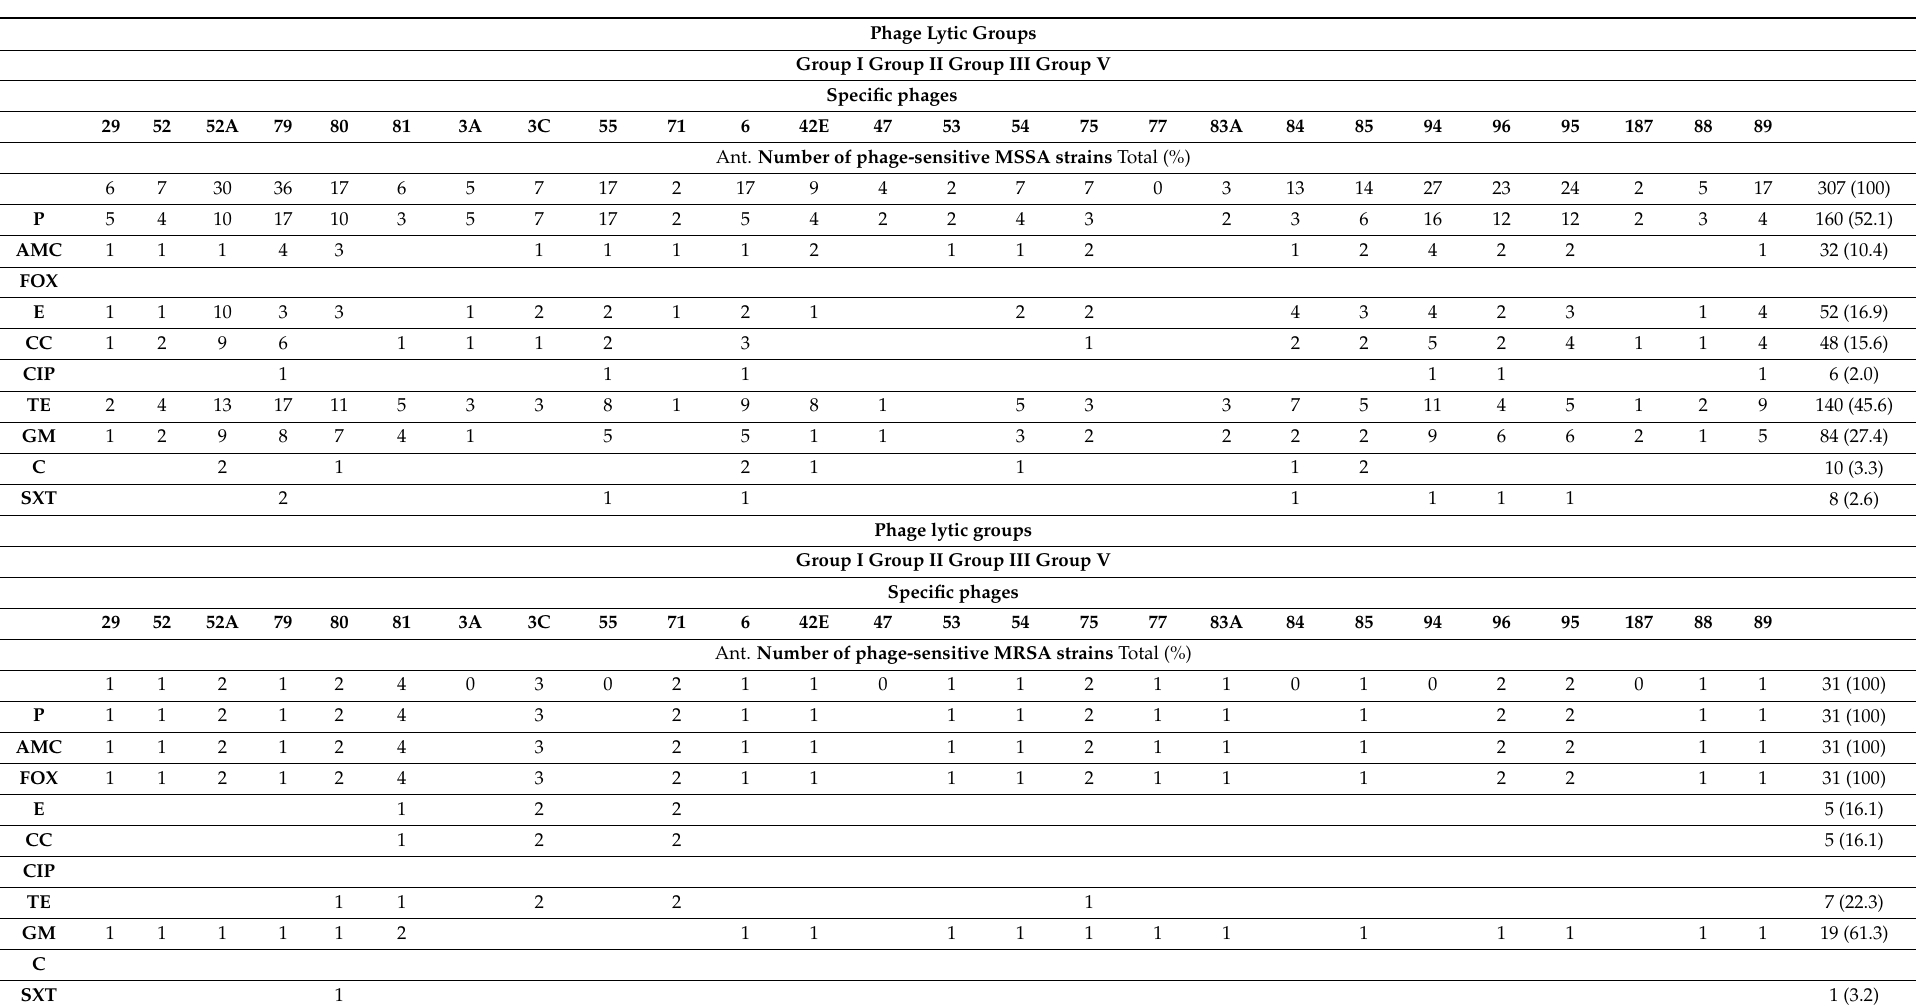
Table 2. Sensitivity to specific lytic phages of MSSA and MRSA 110 oral S. aureus strains and their antibiotic resistance. P—penicillin; AMC—amoxicillin/clavulanic acid; FOX—cefoxitin; E—erythromycin; CC—clindamycin; CIP—ciprofloxacin; GM—gentamicin; TE—tetracycline;